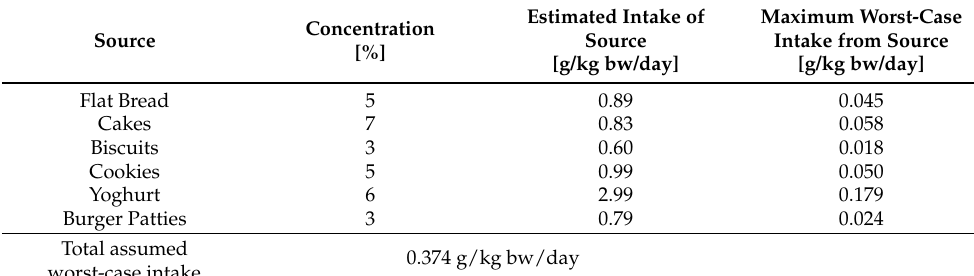
Table 4. Estimation of intake of coffee silver skin from various